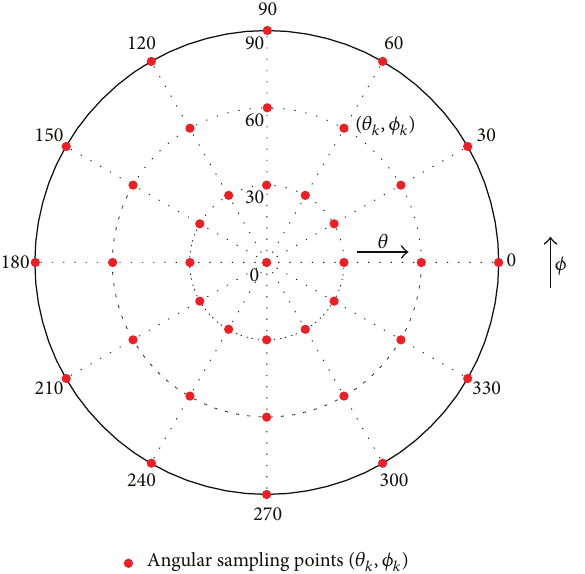
Figure 1: Sketch of the discretized observation domain for CS- based DoAs estimations.